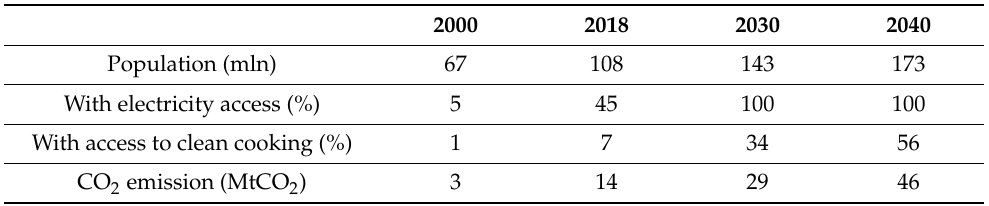
Table 6. Development of Electrification in